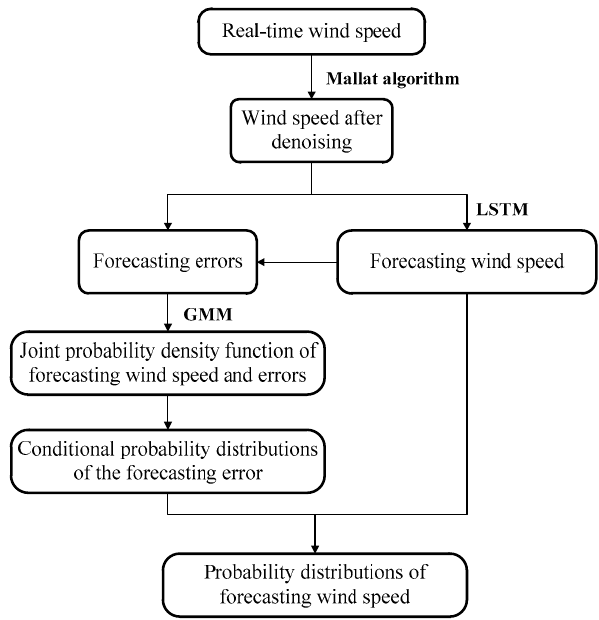
Figure 1. Flowchart of proposed method.